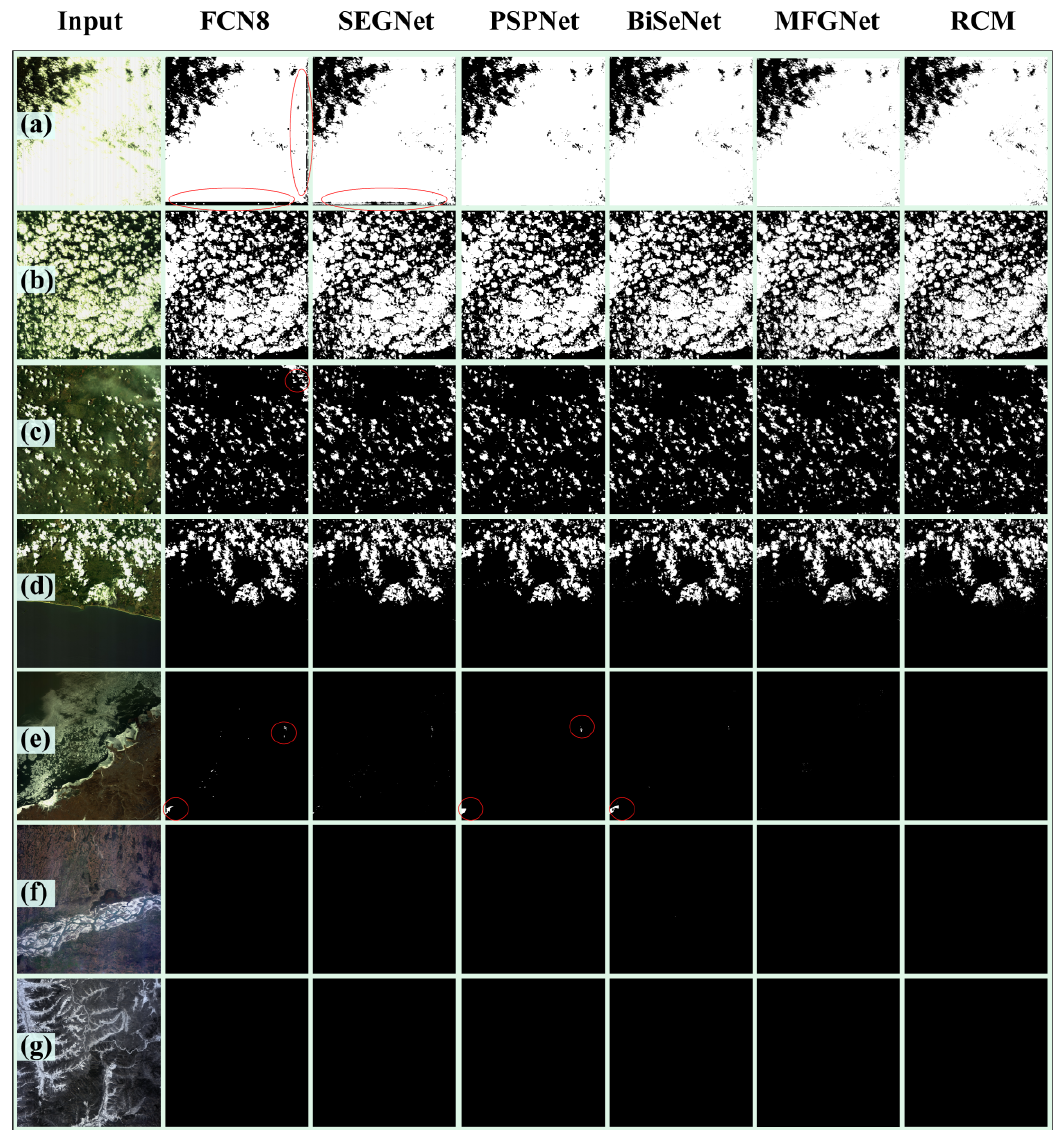
Figure 11. Comparison of cloud segmentation of CNN-based methods in the presence of cloud and ice. ( a – d ) are for cloud-only cases, and ( e – g ) are for ice and snow coexisting cases. All sizes of RGB images are 2008 × 2083. Abbreviations: RCM, reference cloud mask.